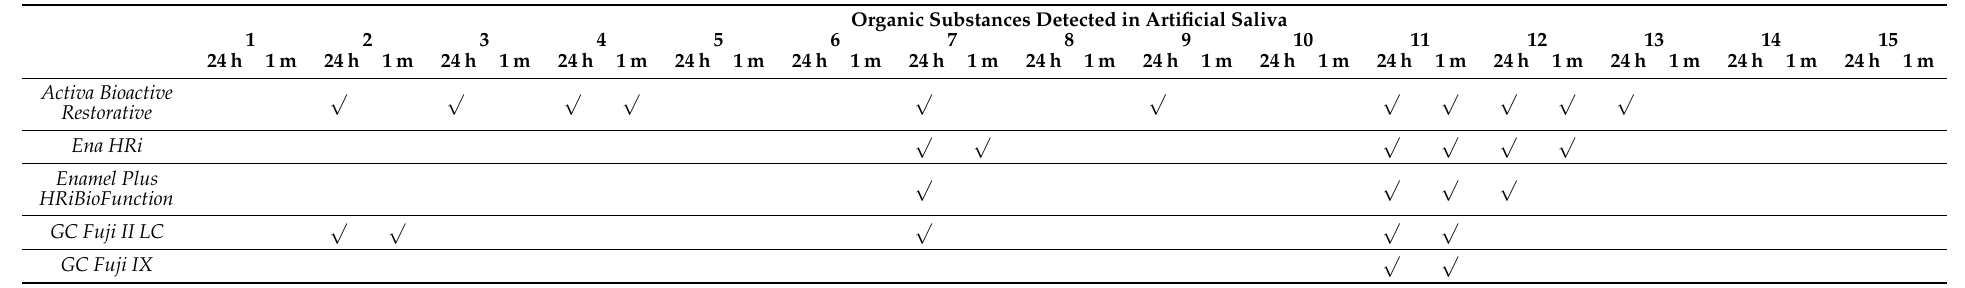
Table 2. Analytes detected in artificial saliva of the five investigated materials for both observation periods (24 h and 1 month). The numbers correspond to the eluates reported in Table 1. Organic Substances Detected in Artificial Saliva 1